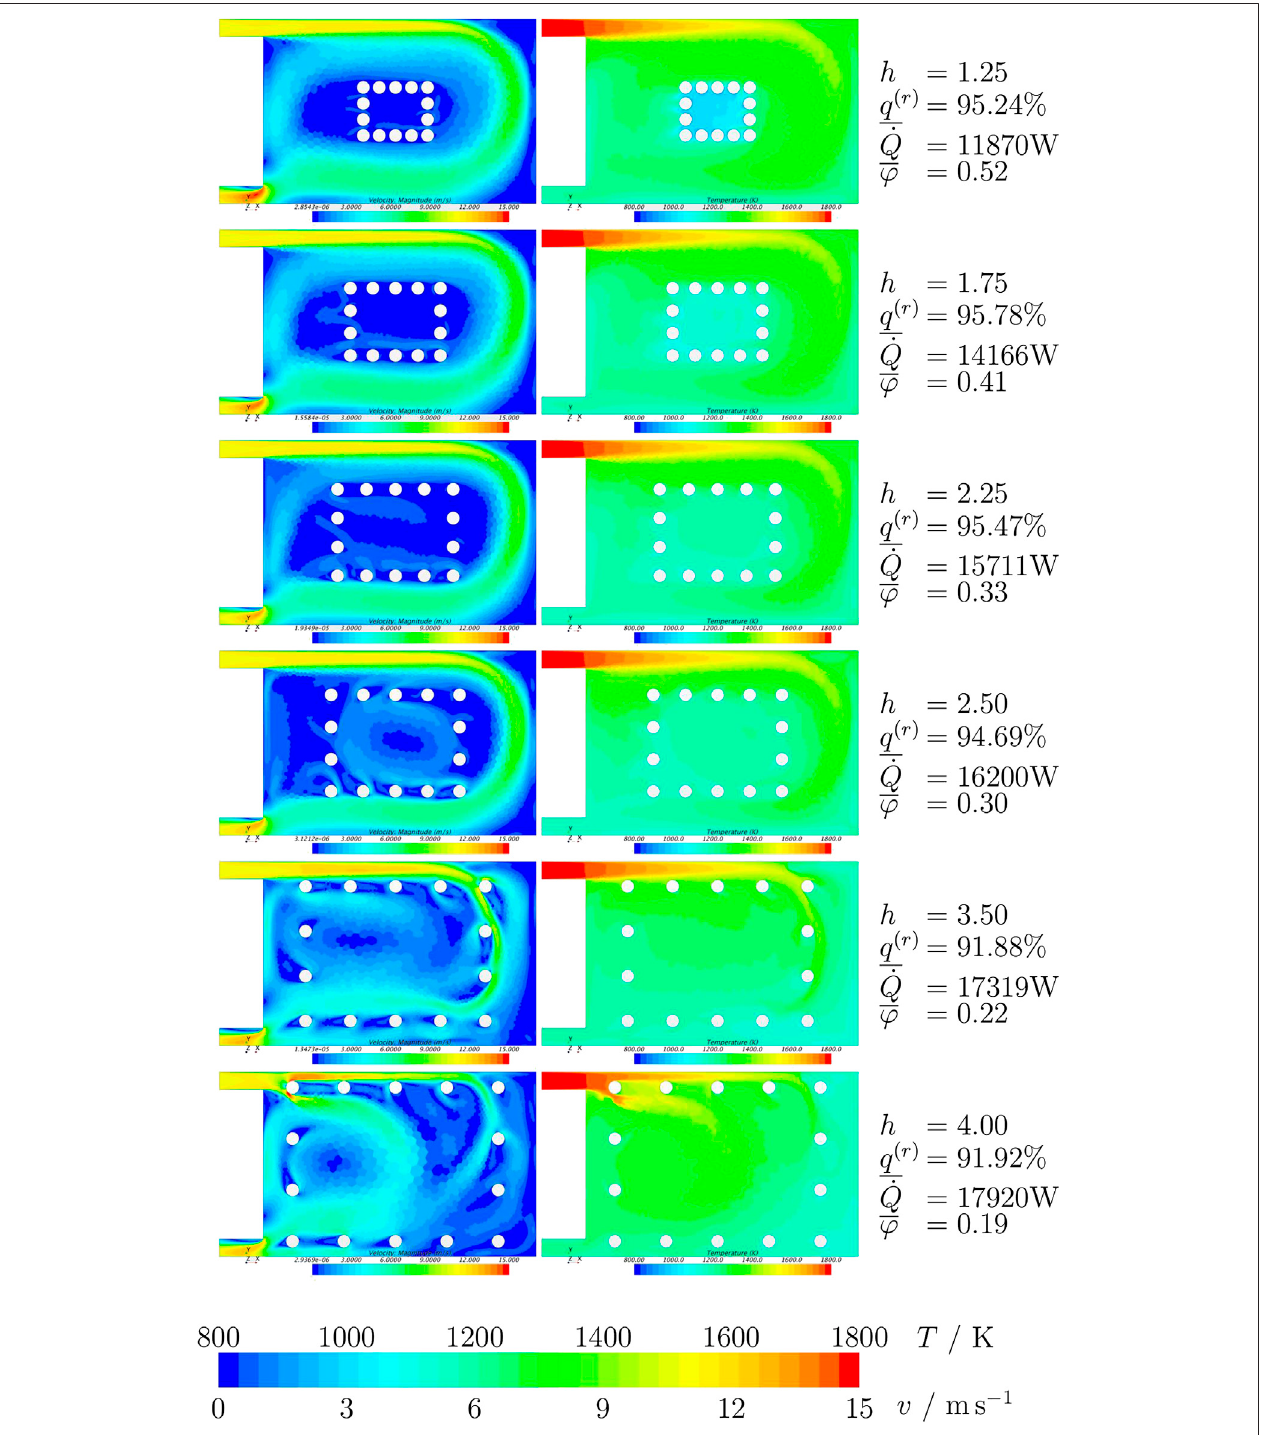
FIGURE7| Velocitymagnitude (leftcolumn) andtemperature fi elds (rightcolumn) forthecon fi gurationDatdifferentdistancefactorswithaninnertuberadiusof r (cid:2) 0 . 063m, and a fl ue gas mass fl ow of _ m / t (cid:2) 0 . 03kg / s / tube.